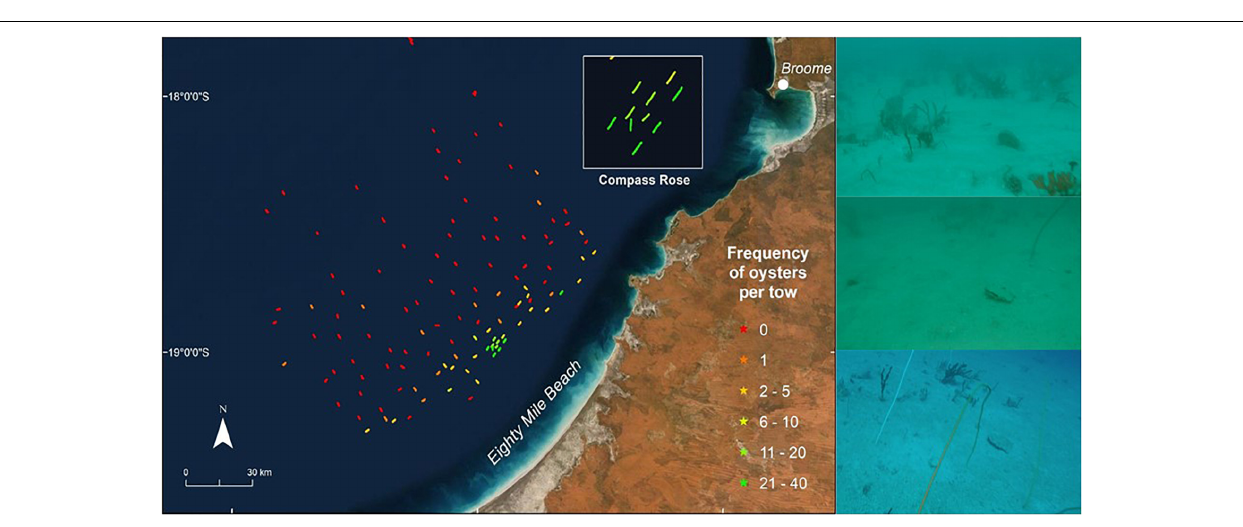
FIGURE 4 | Distribution and relative abundance of pearl oysters, P. maxima , observed during towed video transects across the study area offshore from Eighty Mile Beach. Towed video transects where no oysters were observed are in red, with other transects coloured according to the frequency of oysters observed. The maximum number of oysters seen on a single transect was 37. Photographs show examples of pearl oysters observed on the sea floor using the AIMS towed video platform. Basemaps sourced from ESRI, DigitalGlobe, GeoEye, Earthstar Geographics, CNES/Airbus DS, USDA, USGS, AeroGRID, IGN and the GIS User